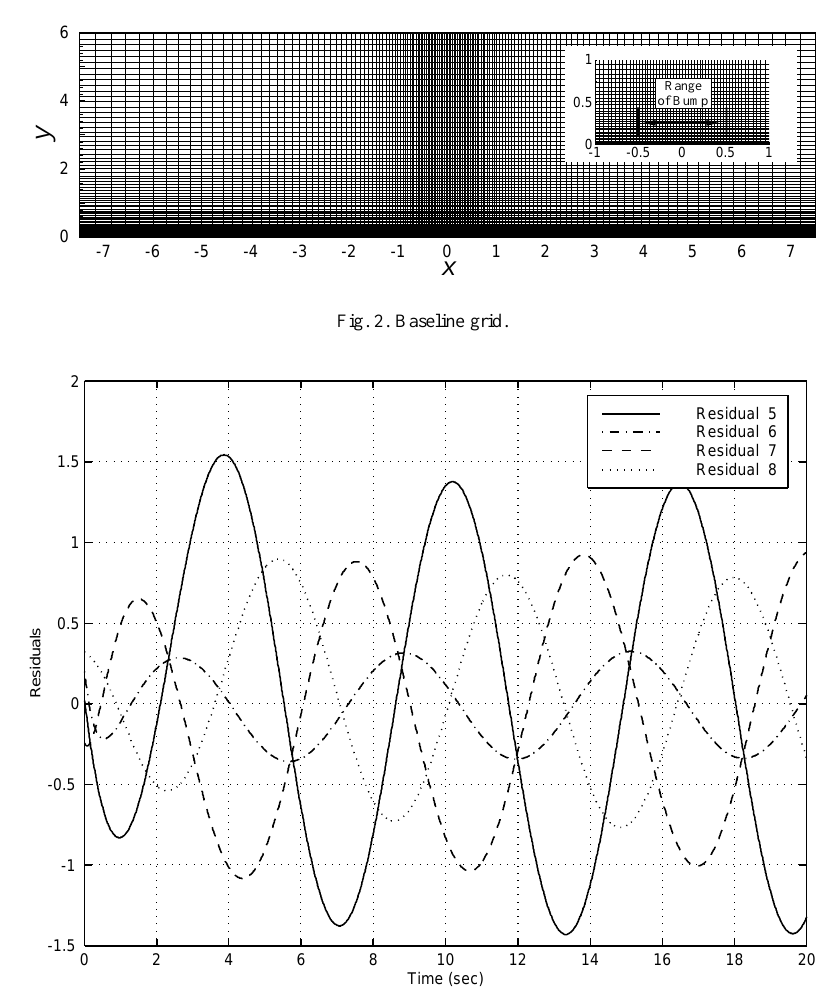
Fig. 3. Residuals 5–8 for 4 mode simulation with δ 1 = 0 . 005